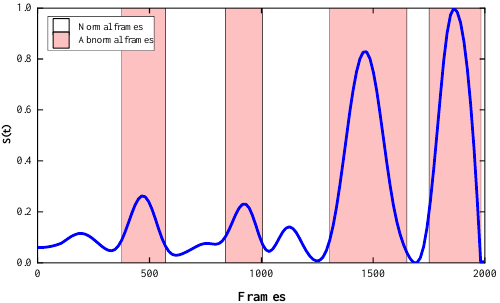
Figure 5. The St curves of a clip in the construction site dataset.